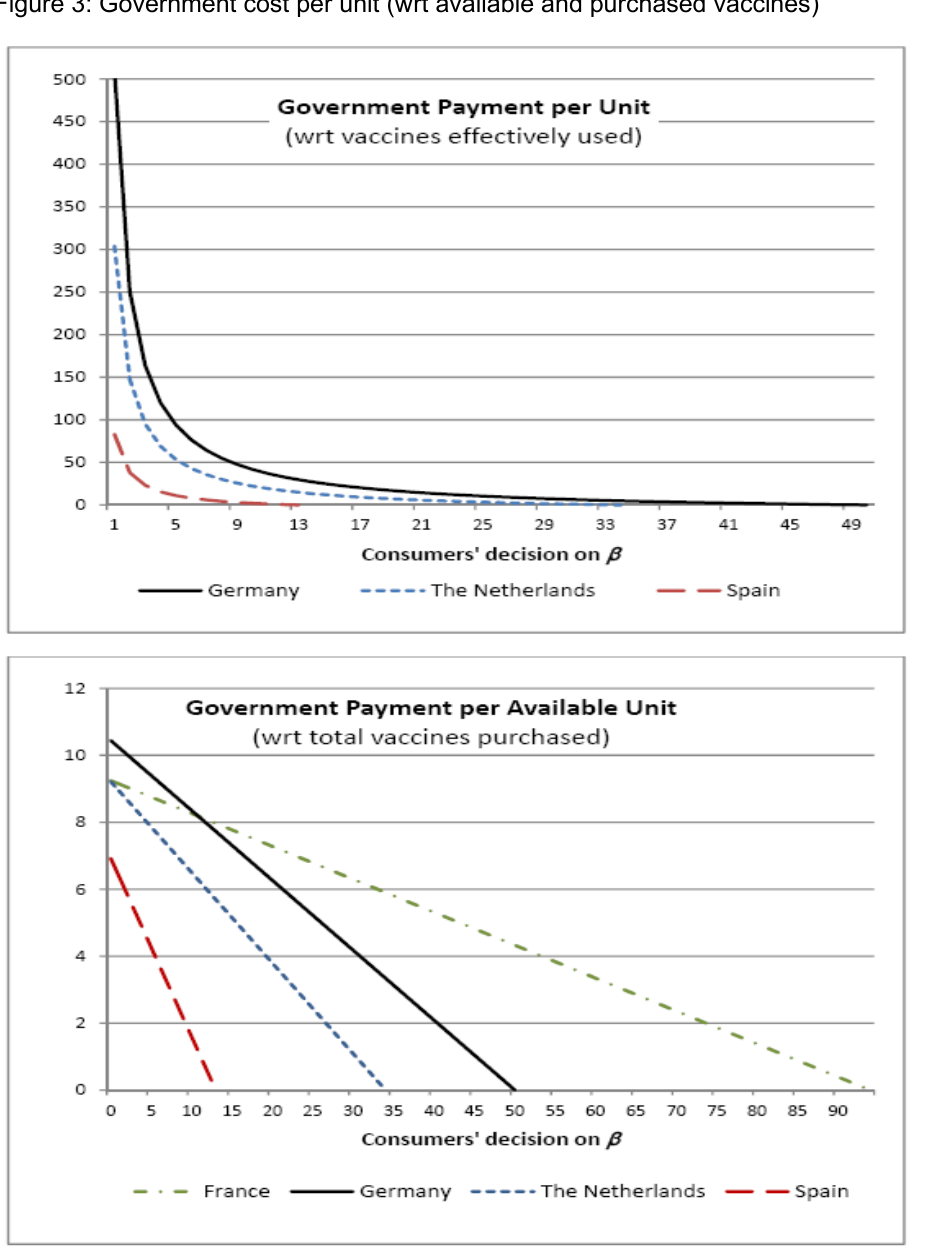
Figure 3: Government cost per unit (wrt available and purchased